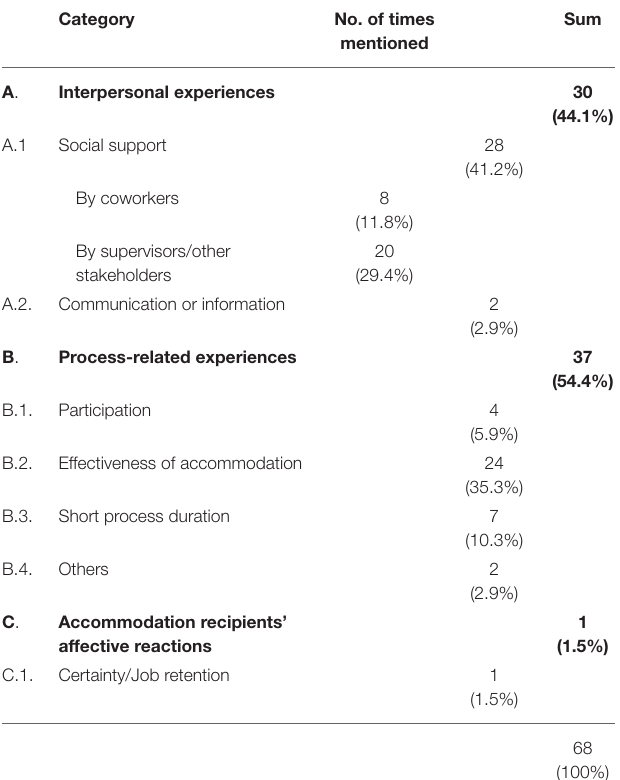
TABLE 3 | Final categorization of recipients’ positive experiences (the percentage of total positive codings appears in